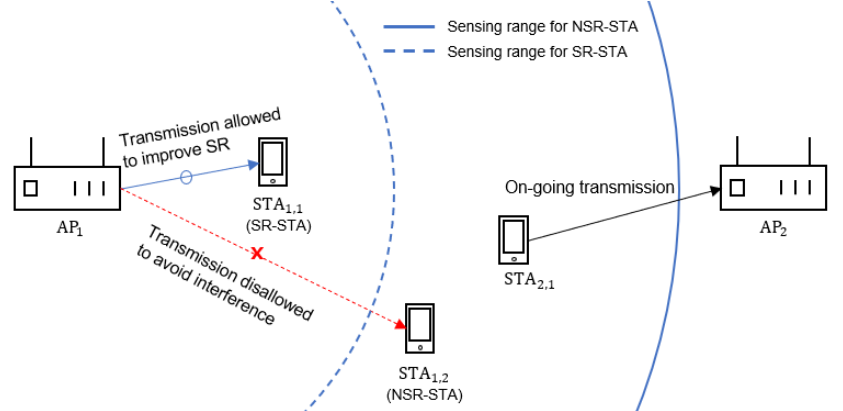
Figure 2. Operational example of spatial reuse by the dual channel access